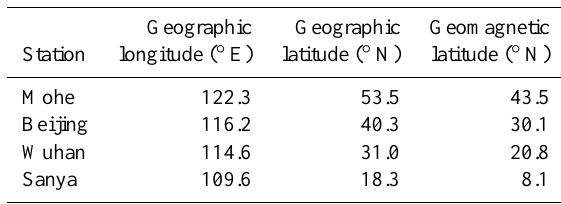
Table 1. Coordinates of the ionosonde stations.